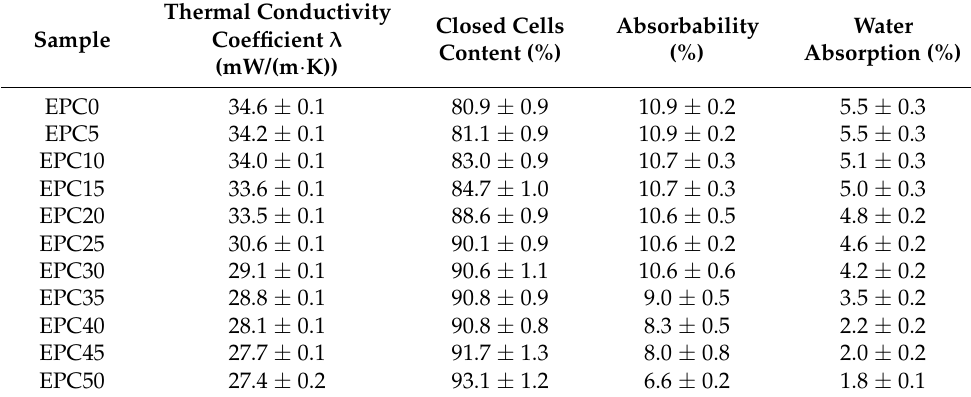
Table 3. Thermal insulation properties of RPU/PIR modified by